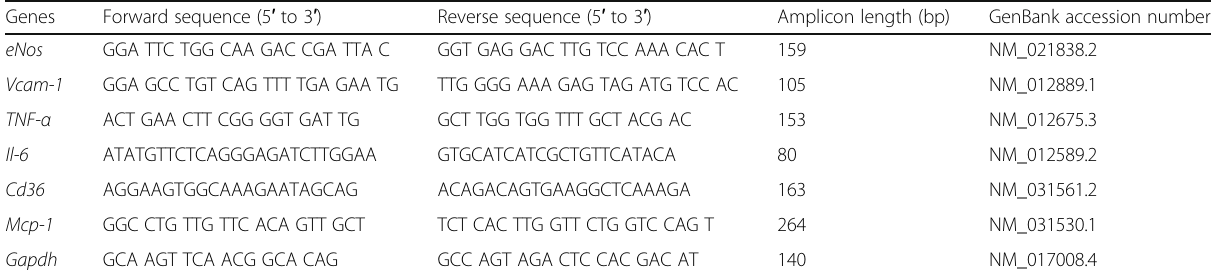
Table 1 The primer details used for real-time PCR analysis Genes Forward sequence (5 ′ to 3 ′ ) Reverse sequence (5 ′ to 3 ′